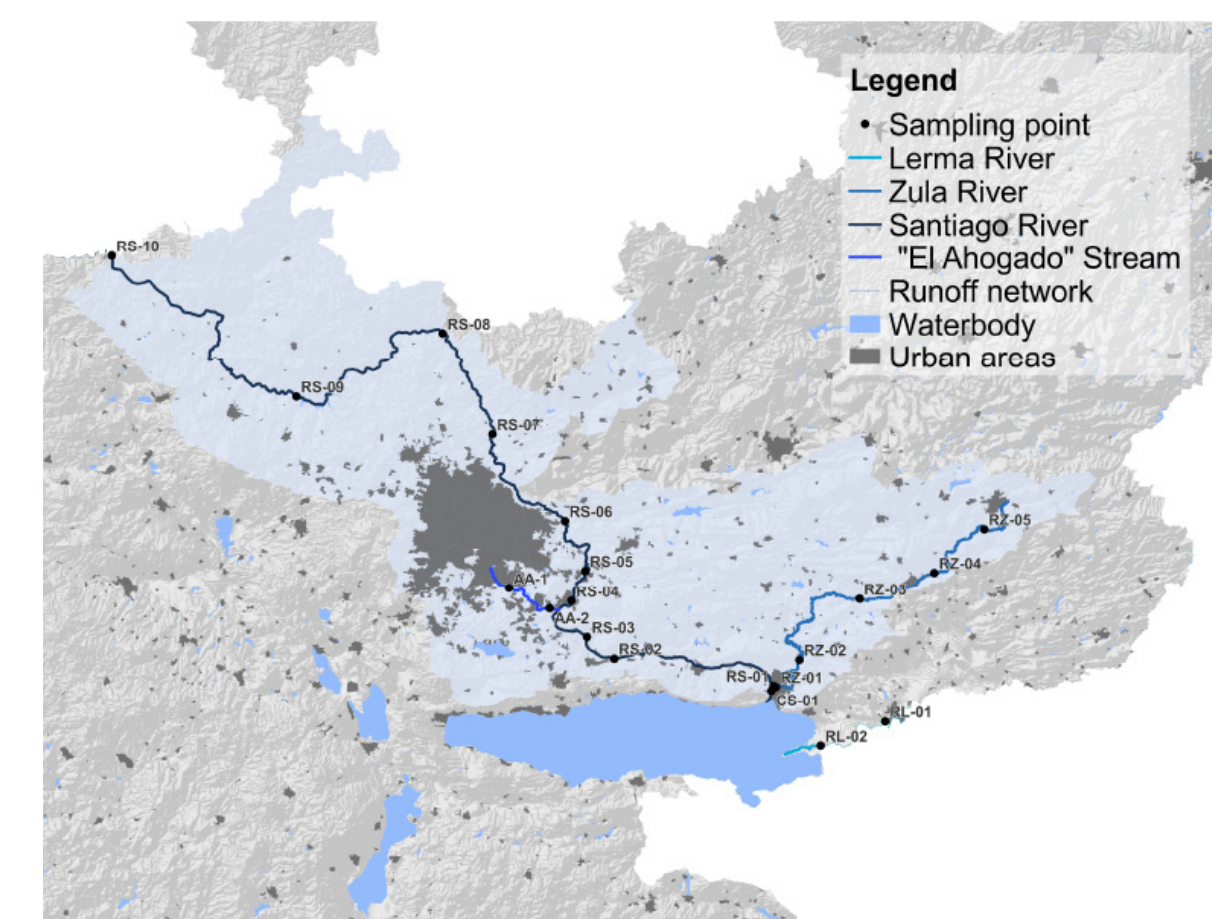
Figure 1. Sampling points along the Santiago-Guadalajara River (SGR).